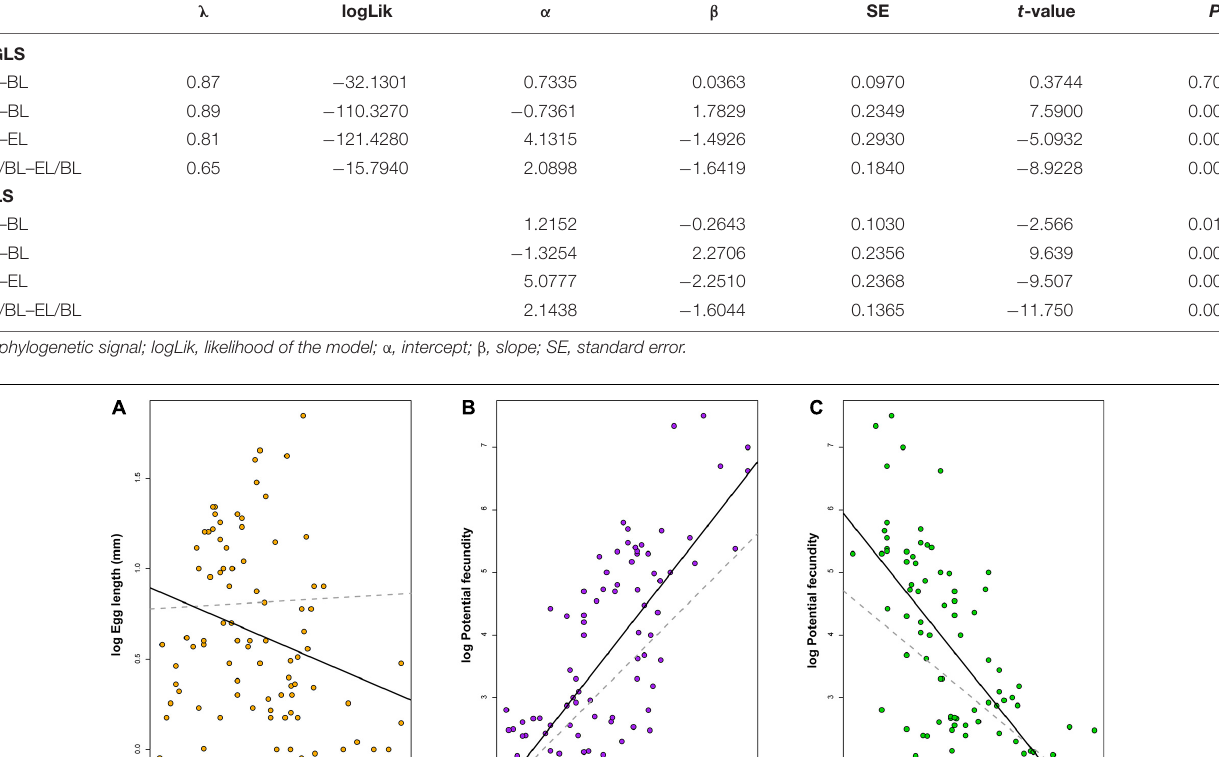
TABLE 2 | Parameters of the relationship among body length (BL), egg length (EL), and potential fecundity (PF) of cephalopods obtained by phylogenetic generalized least squares (PGLS) and ordinary least squares (OLS) analyses. λ logLik α β SE t -value P